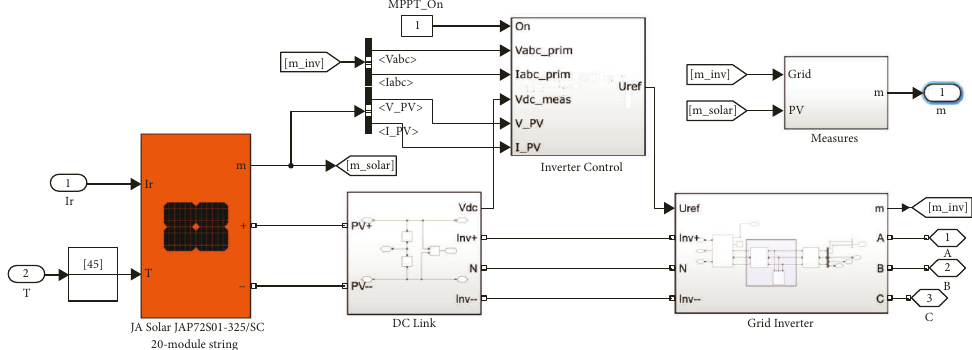
Figure 8: The photovoltaic system circuit.